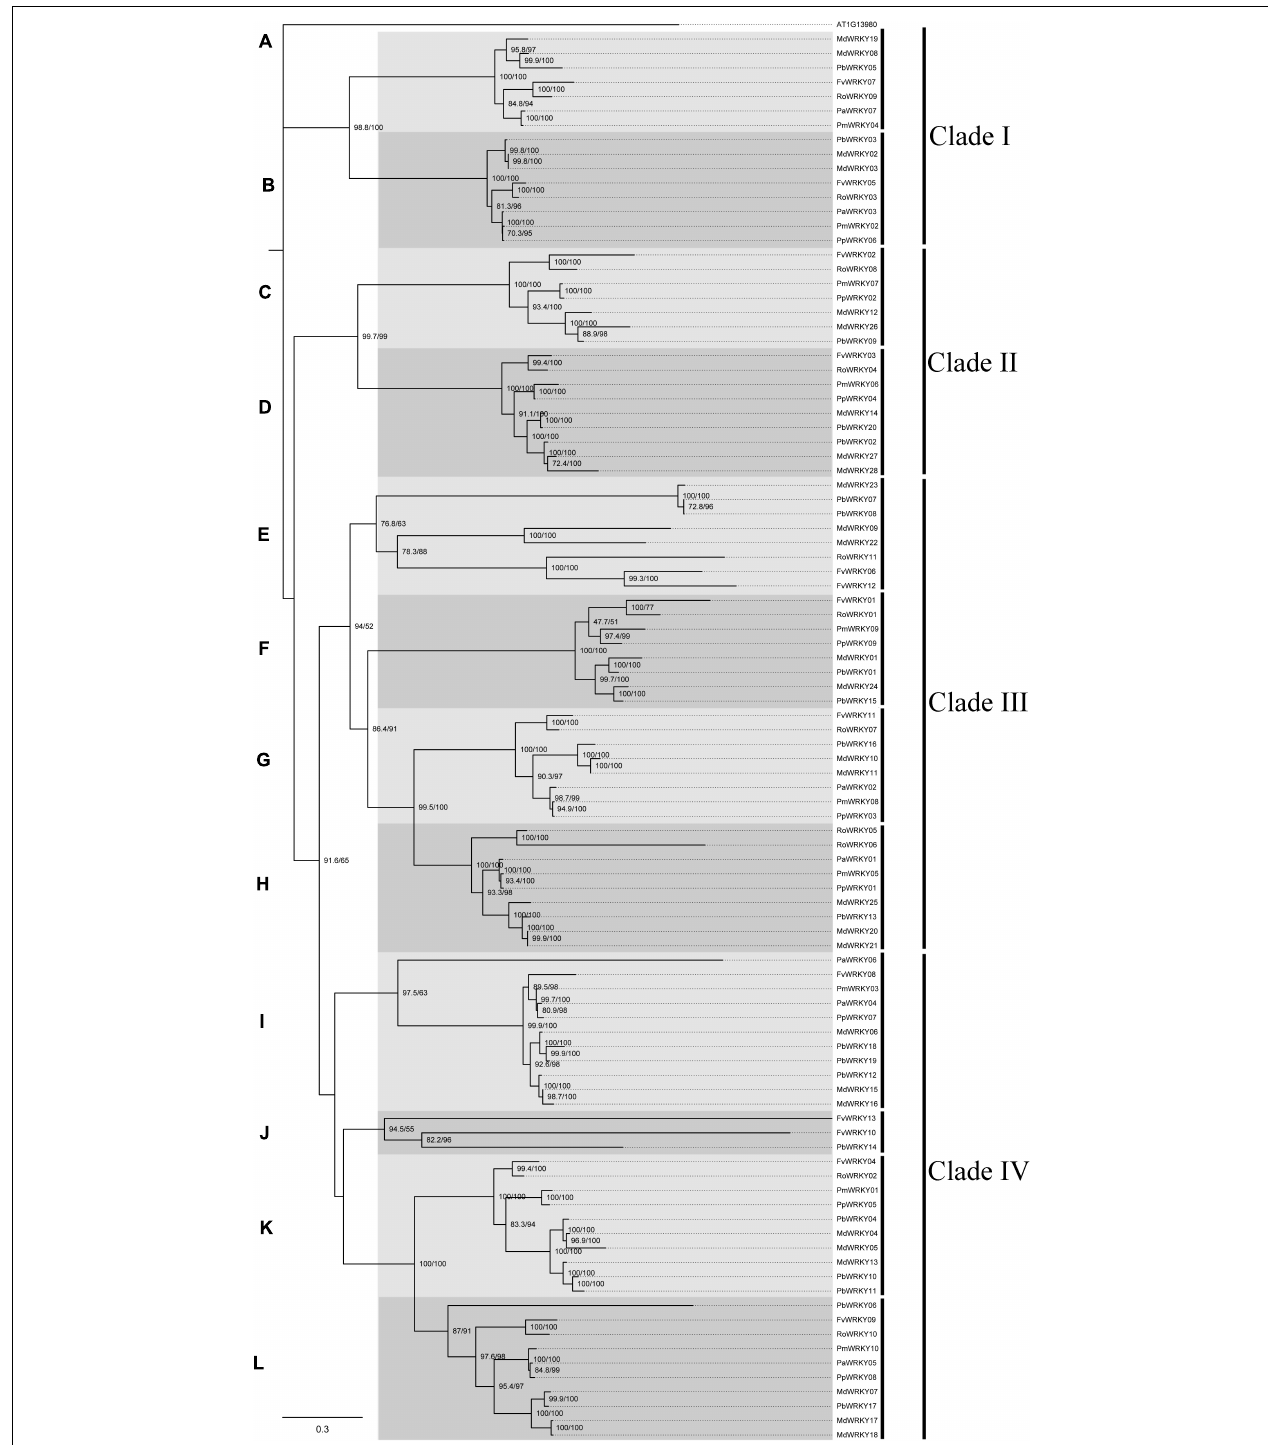
FIGURE 2 | Maximum-Likelihood tree based on sequences of WRKY I genes from P. avium , P. persica , P. mume , R. occidentalis , F. vesca , P. bretschneideri , and M. domestica . The IQ-tree software was used to perform maximum likelihood (ML) phylogenetic analysis with a bootstrap test for 1,000 replicates and an SH-aLRT test for 1,000 random addition replicates. Based on the evolutionary distances and bootstrap support, this tree was divided into 12 subgroups. The tree is rooted to the A. thaliana WRKY I gene (AT1G13980).